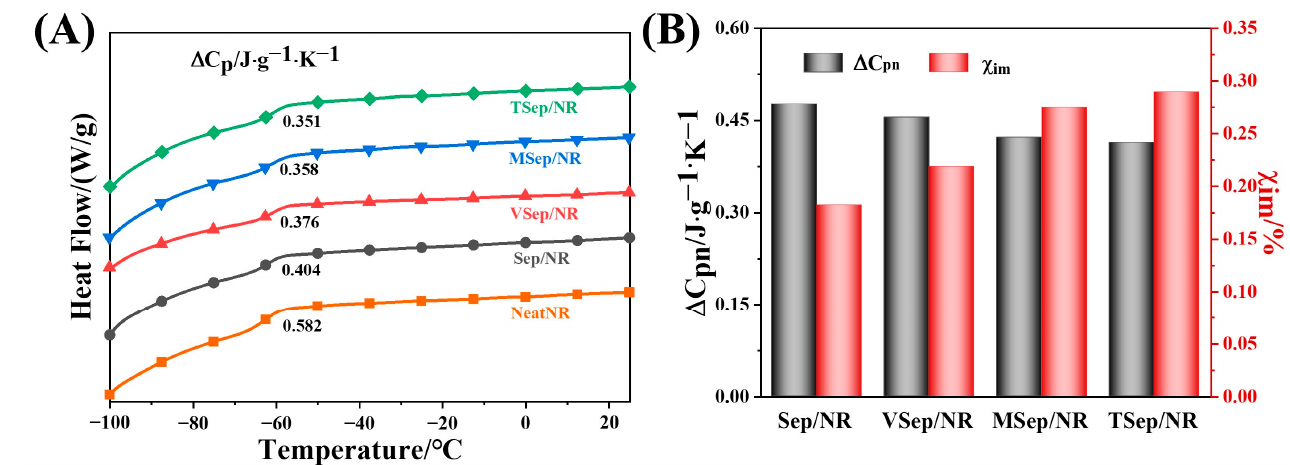
Figure 7. ( A ) DSC curves and ( B ) ∆ C pn and χ im, of sepiolite/NR composites.